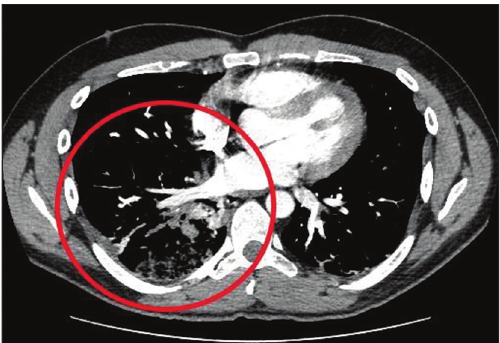
FIGURE 7. Chest CT angiography – January 29,